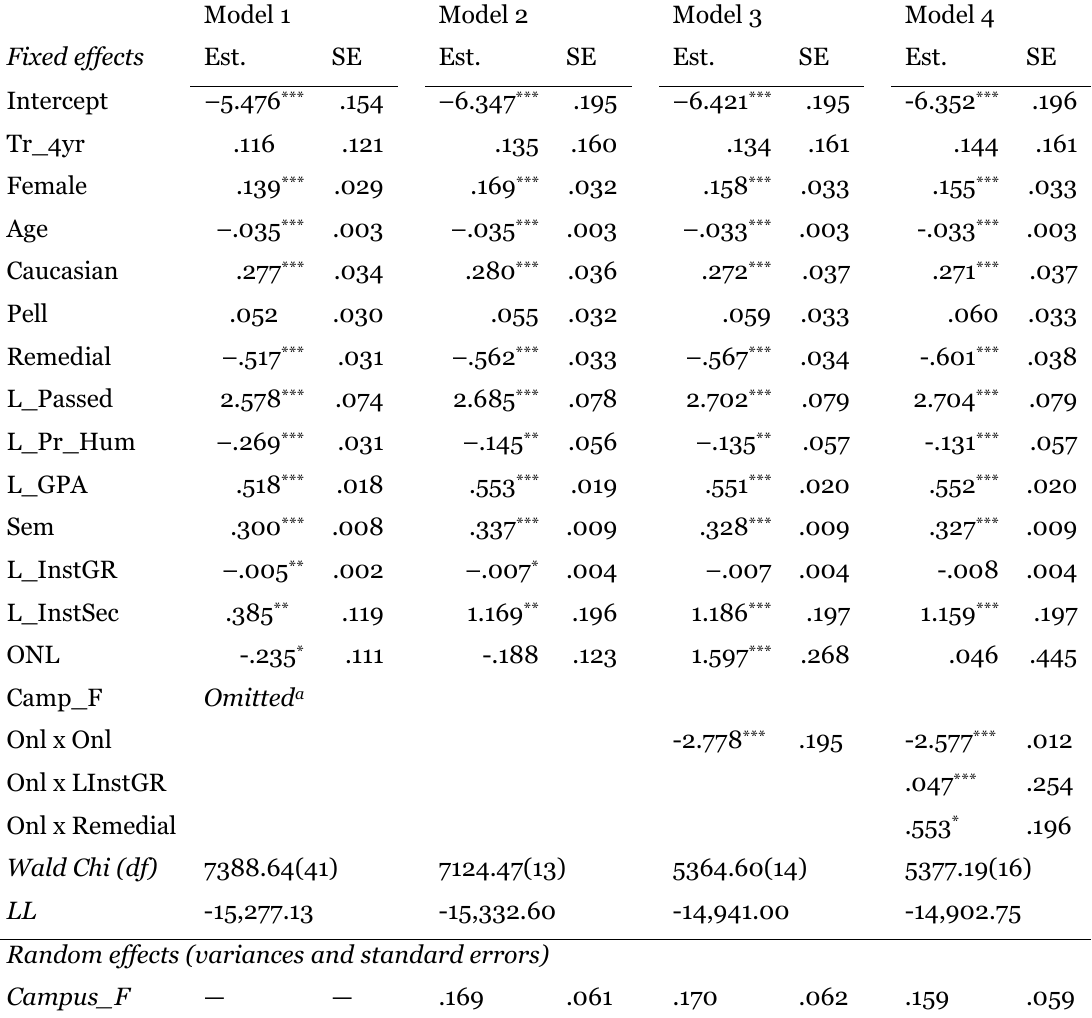
Table 2 Results from Multilevel Logistic Analysis